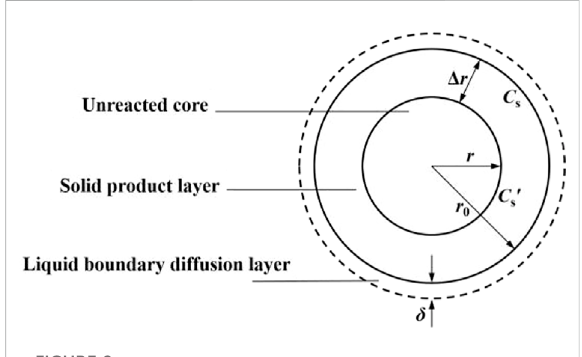
FIGURE 2 Schematicdiagramofbacterialdesulfurizationkinetic model.